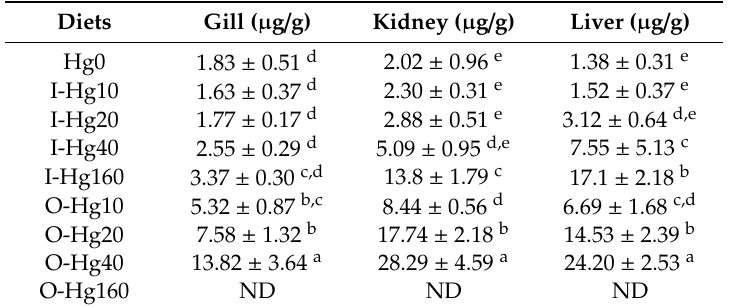
Table 4. Tissue mercury concentrations ( µ g / g of wet matter basis) of juvenile olive flounder, Paralichthys olivaceus, fed experimental diets for eight weeks 1 .